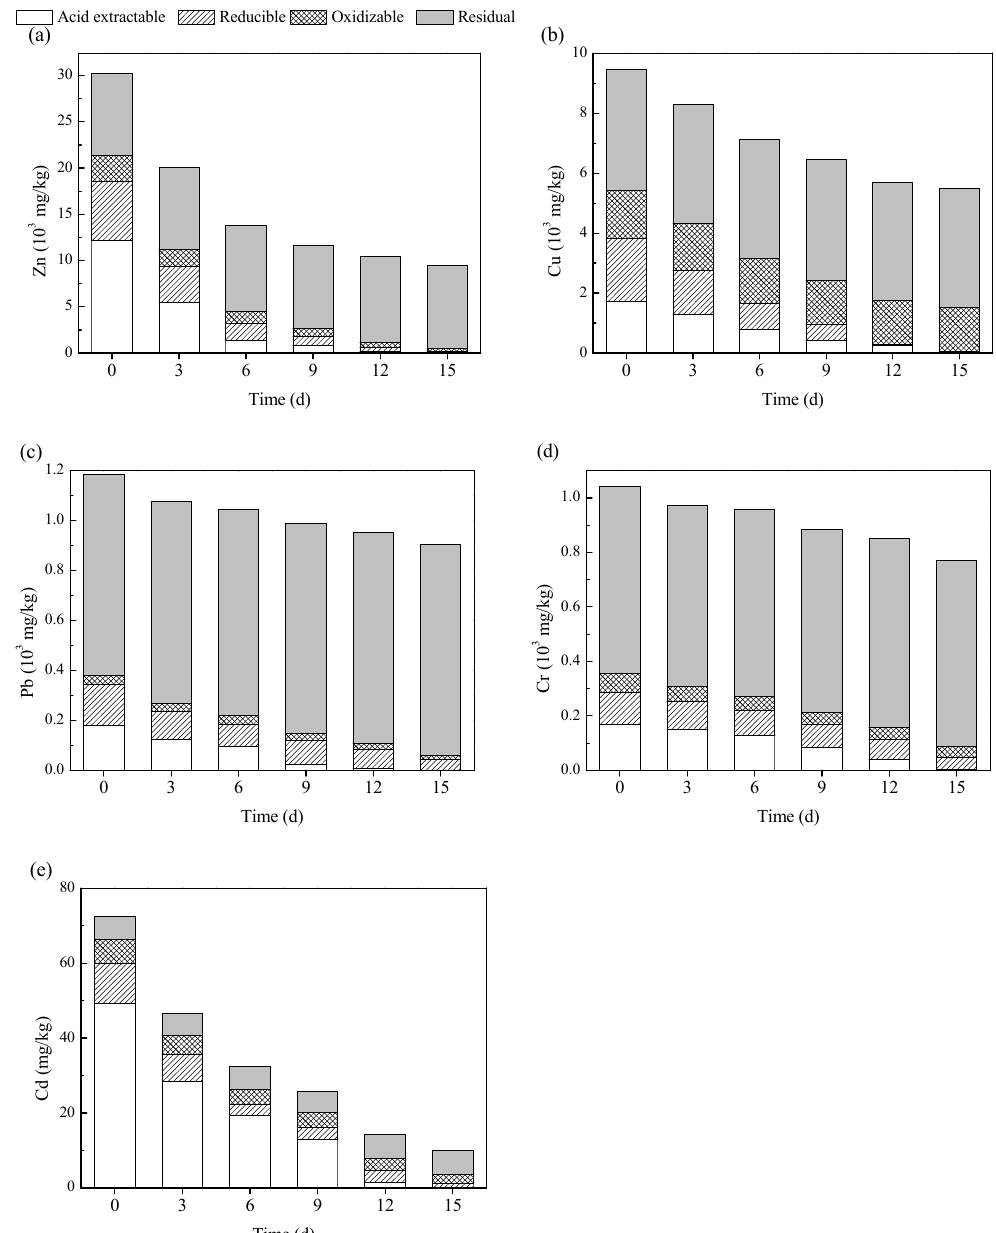
Figure 5. Variation in partitioning of chemical forms of Zn ( a ), Cu ( b ), Pb ( c ), Cr ( d ), and Cd ( e ) during bioleaching with sulfur powder.